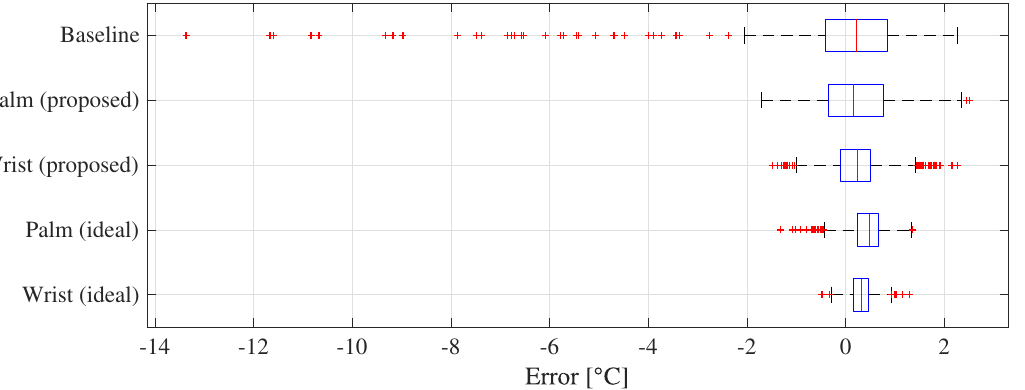
Figure 10. Error distributions of face temperature.